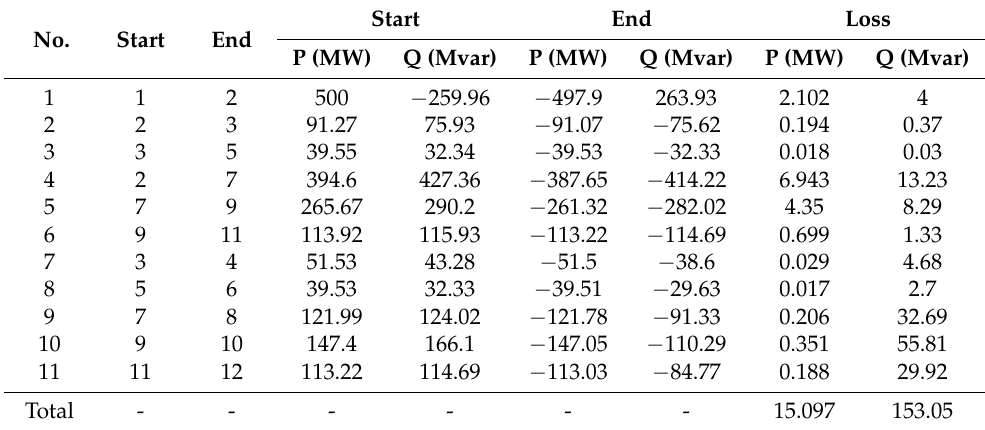
Table 20. Calculation results of the different lines in the power supply network.